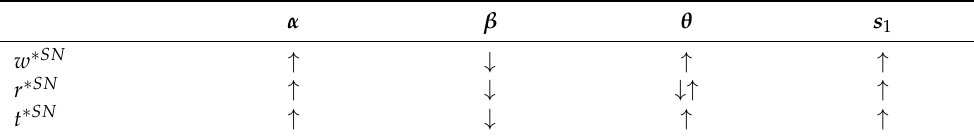
Table 5. The sensitivities of optimal operation policy to model parameters for Strategy SN. α β θ s 1 w ∗ SN